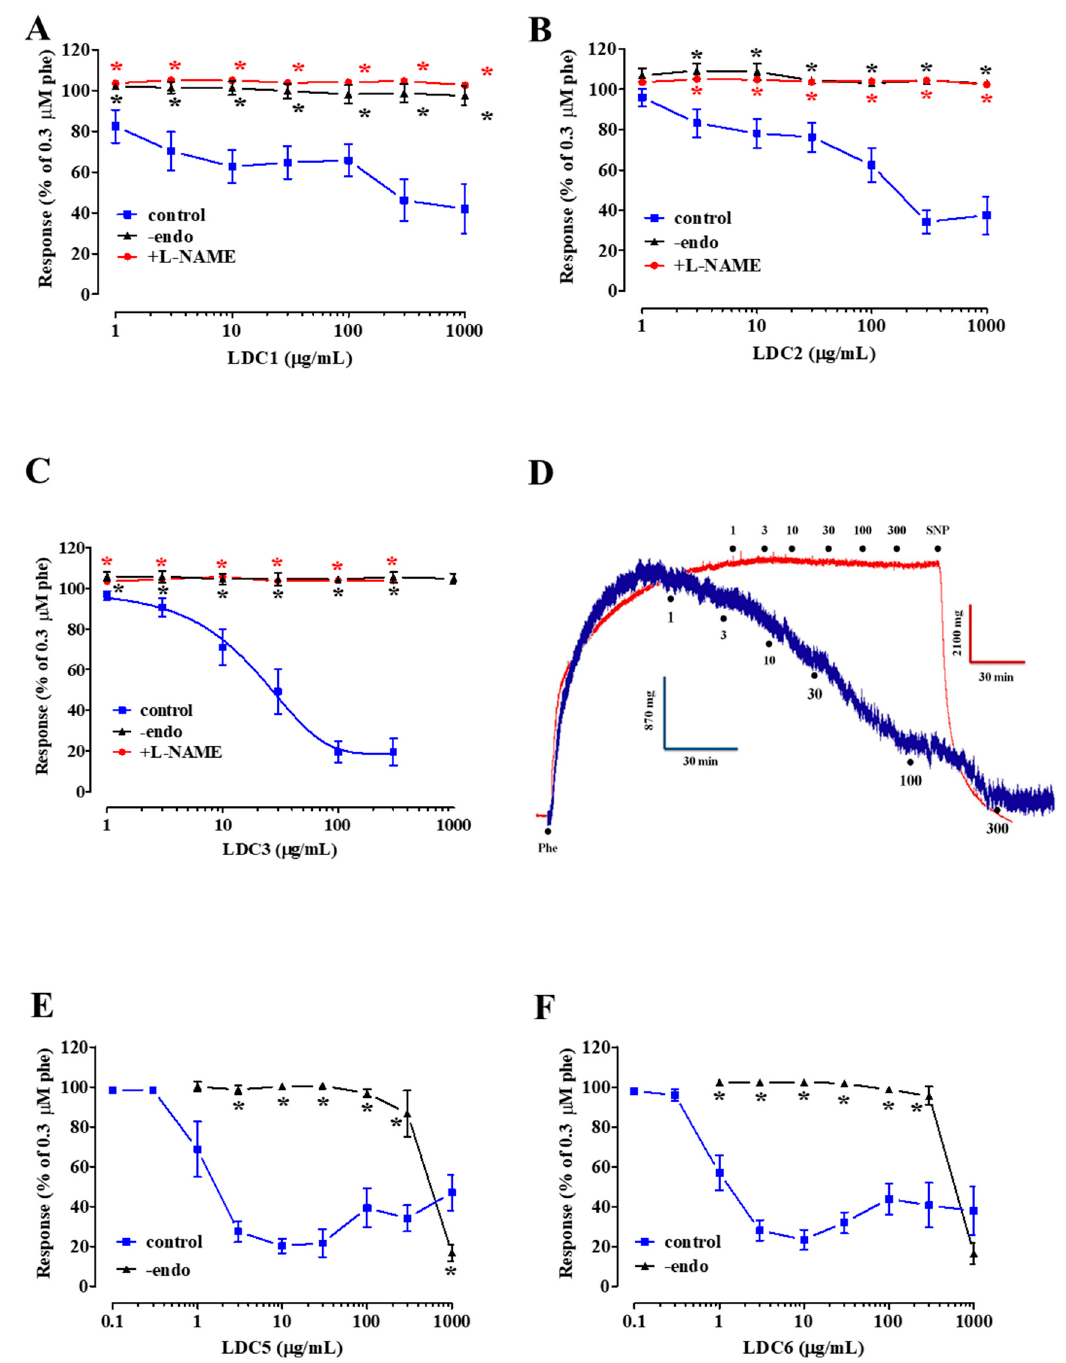
Figure 2. Effects of LDC extracts on phenylephrine-induced contraction in either endothelium-intact or deprived rat aorta rings. Endothelium-intact (control) or -denuded (-endo) rings, pre-contracted by 0.3 µM phenylephrine, were challenged with cumulative concentrations of ( A ) LDC1 , ( B ) LDC2 , ( C ) LDC3 , ( E ) LDC5 , and ( F ) LDC6 . Some experiments were performed in endothelium-intact rings pre-incubated with 100 µM L-NAME. ( D ) Traces representative of 5–6 similar experiments, showing the effects of LDC3 on endothelium-intact rings in the absence (blue trace) or presence of 100 µM L-NAME (red trace). In the ordinate scale, relaxation is reported as a percentage of the initial tension induced by phenylephrine (Phe). Data points represent mean ± SEM ( n = 4–8). * P < 0.05 vs control, one-way ANOVA or Student’s t test for unpaired samples.